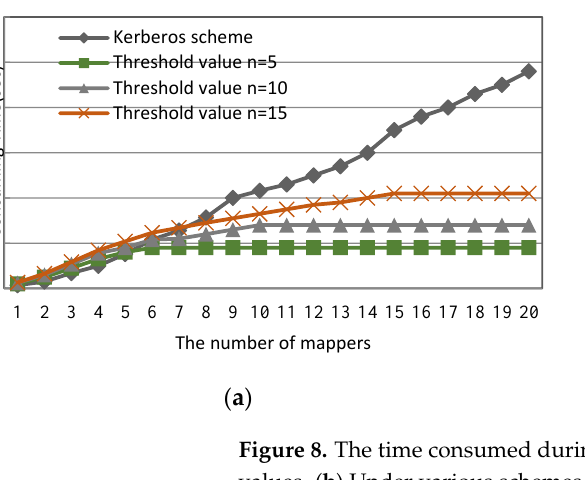
Figure 8. The time consumed during reconstructing the system key, S . ( a ) Under various threshold values. ( b ) Under various schemes and fixed threshold value.